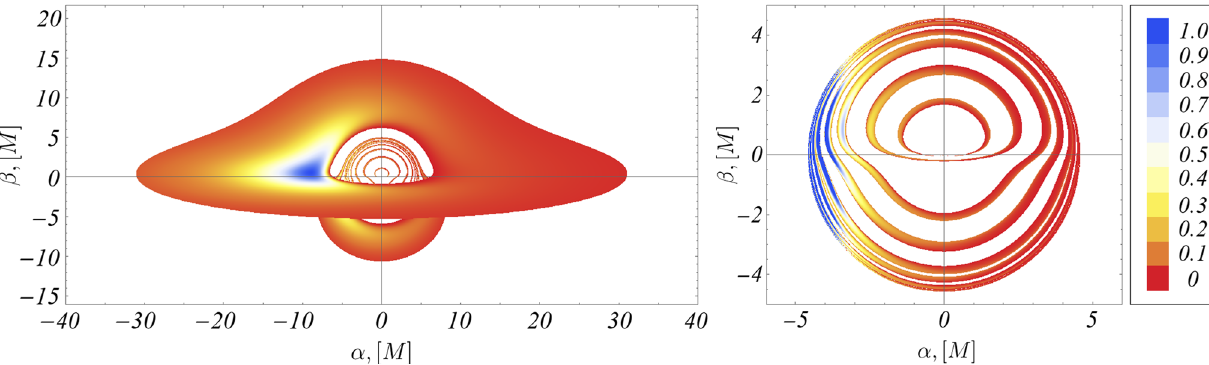
from the outer disk is F out max = 6 . 07 × 10 − 5 M ˙ M , while for the inner disk the flux reaches the value F in max = 4 . 94 × 10 − 2 M ˙ M . The observer is located at r obs = 5000 M , and at the inclination angle i = 80